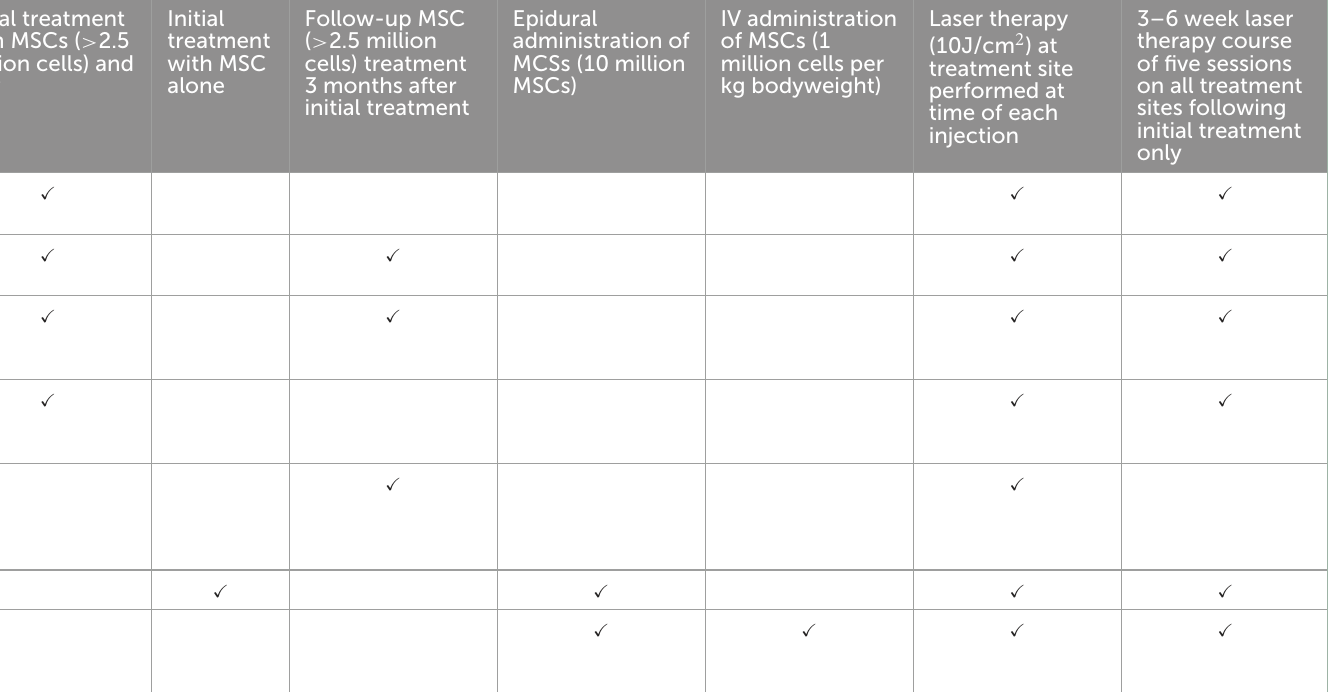
TABLE 2 A summary of the treatment protocol used in all cases depending on the diagnosed pathology and severity in individual